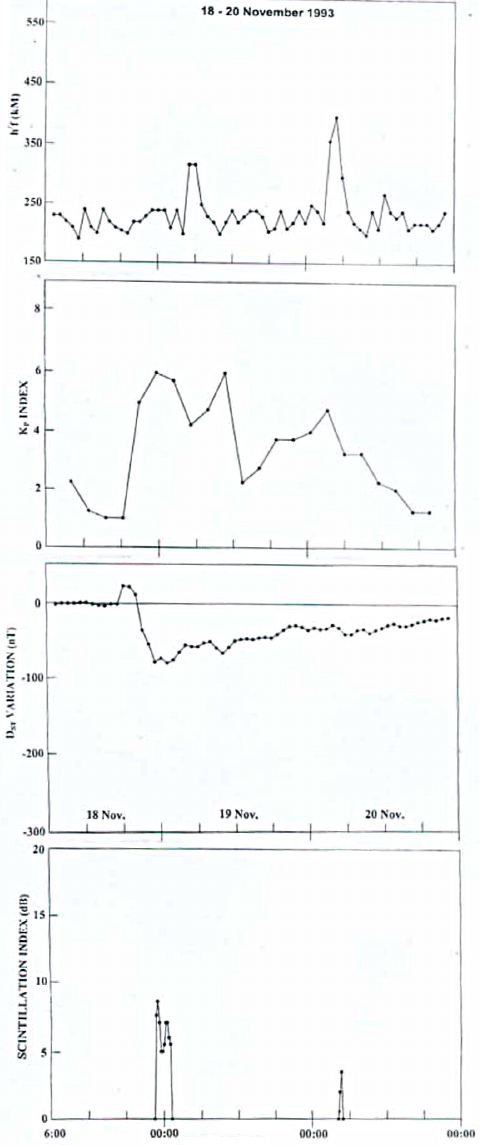
Fig. 9. Example of a magnetic storm that occurred during 18 − 20 November 1993. The top panel is ionospheric F-layer height (h 0 F) at Ahmedabad, the two middle panels are K p and D st and the bot- tom panel shows the occurrence times of scintillation activity at Varanasi.